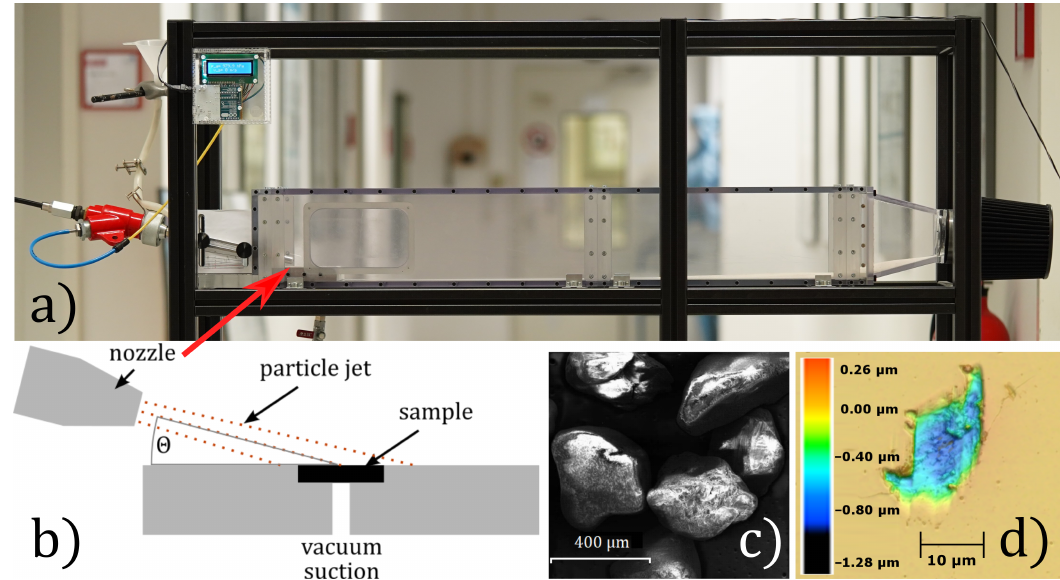
Figure 8. ( a , b ) Photograph and schematic of the setup utilized for reproducible particle blasting experiments, ( c ) the electron micrograph of the particles (silica sand), and ( d ) laser scanning microscope (LSM) image of a typical surface damage topography resulting from particle